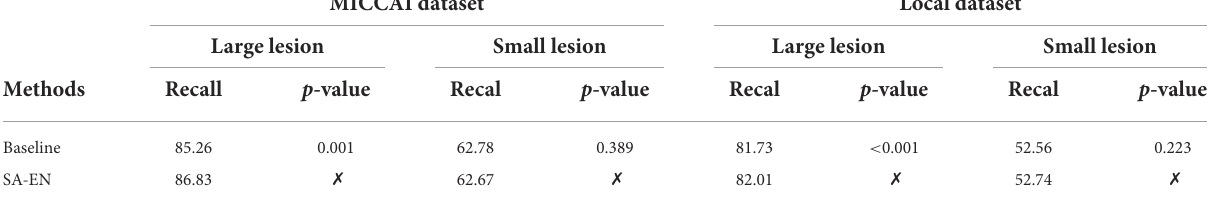
TABLE 4 Performance (Recall) on small and large lesions,